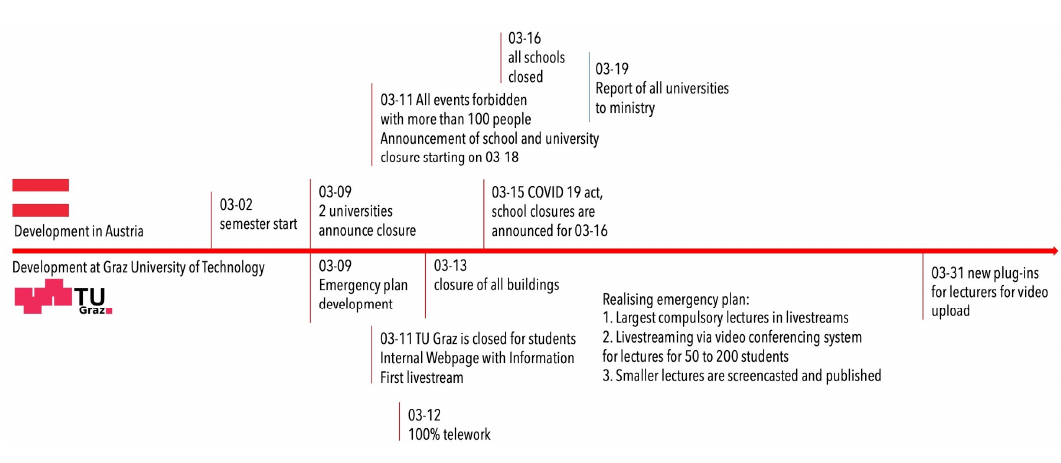
Figure 3. Key measures and development in Austria, at TU Graz and the Educational Technology team during COVID-19 crisis until the end of March 2020.